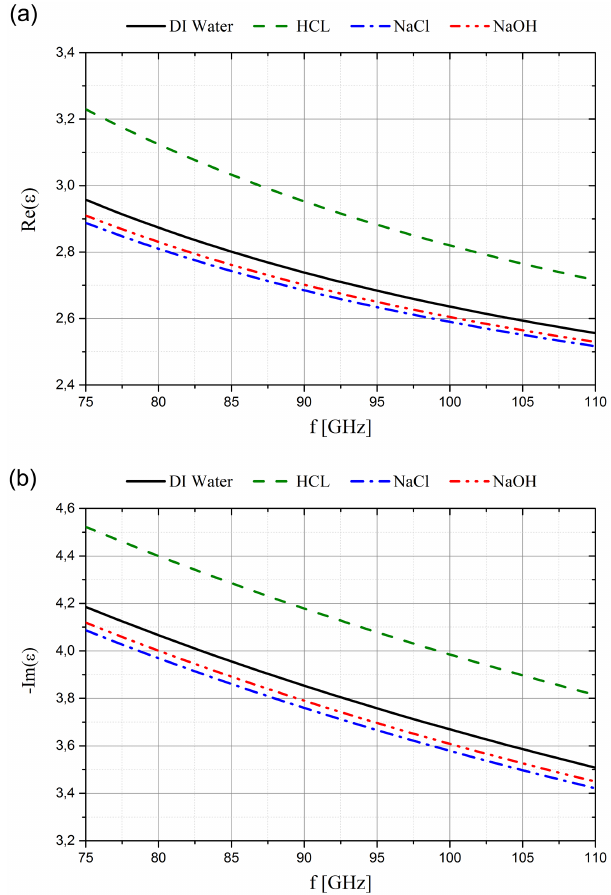
Figure 8. Real and imaginary parts of the dielectric function of dif- ferent water solutions. Due to measurement inaccuracies, the dielec- tric function of the NaCl and NaOH solutions can not be uniquely